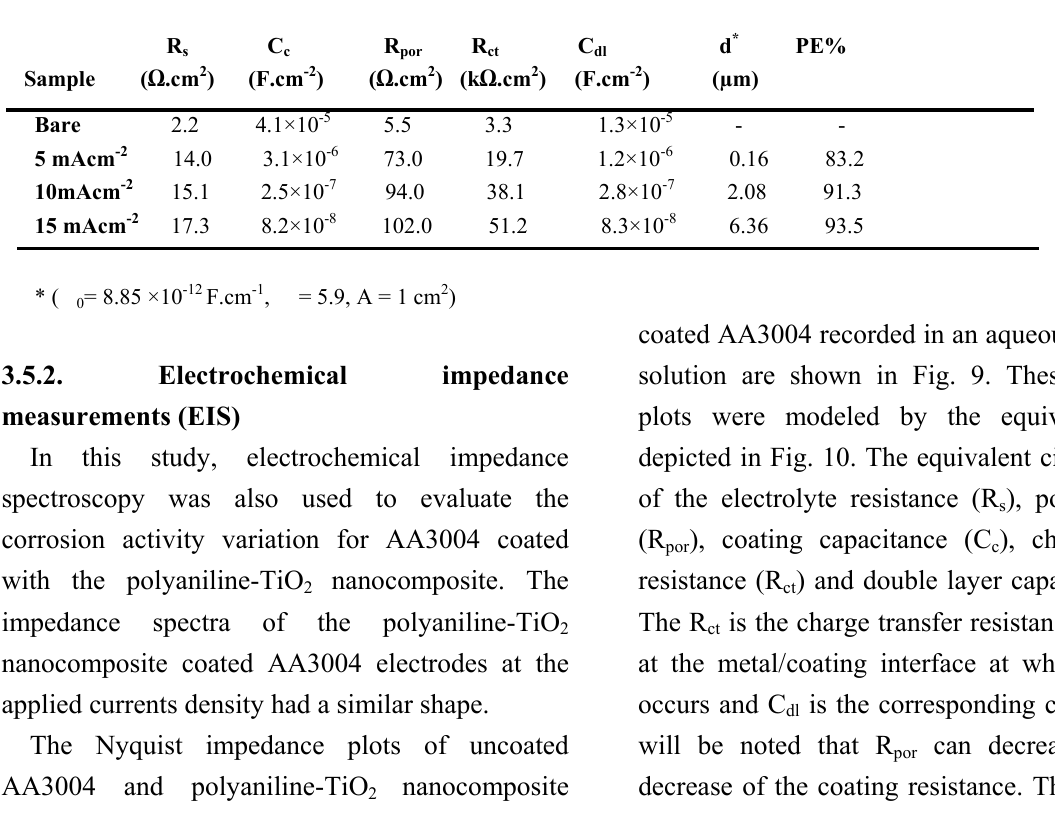
Table 3. Impedance parameter values of the electrosynthesized polyaniline-TiO to the equivalent circuit for the impedance spectra recorded in aqueous 3.5% NaCl